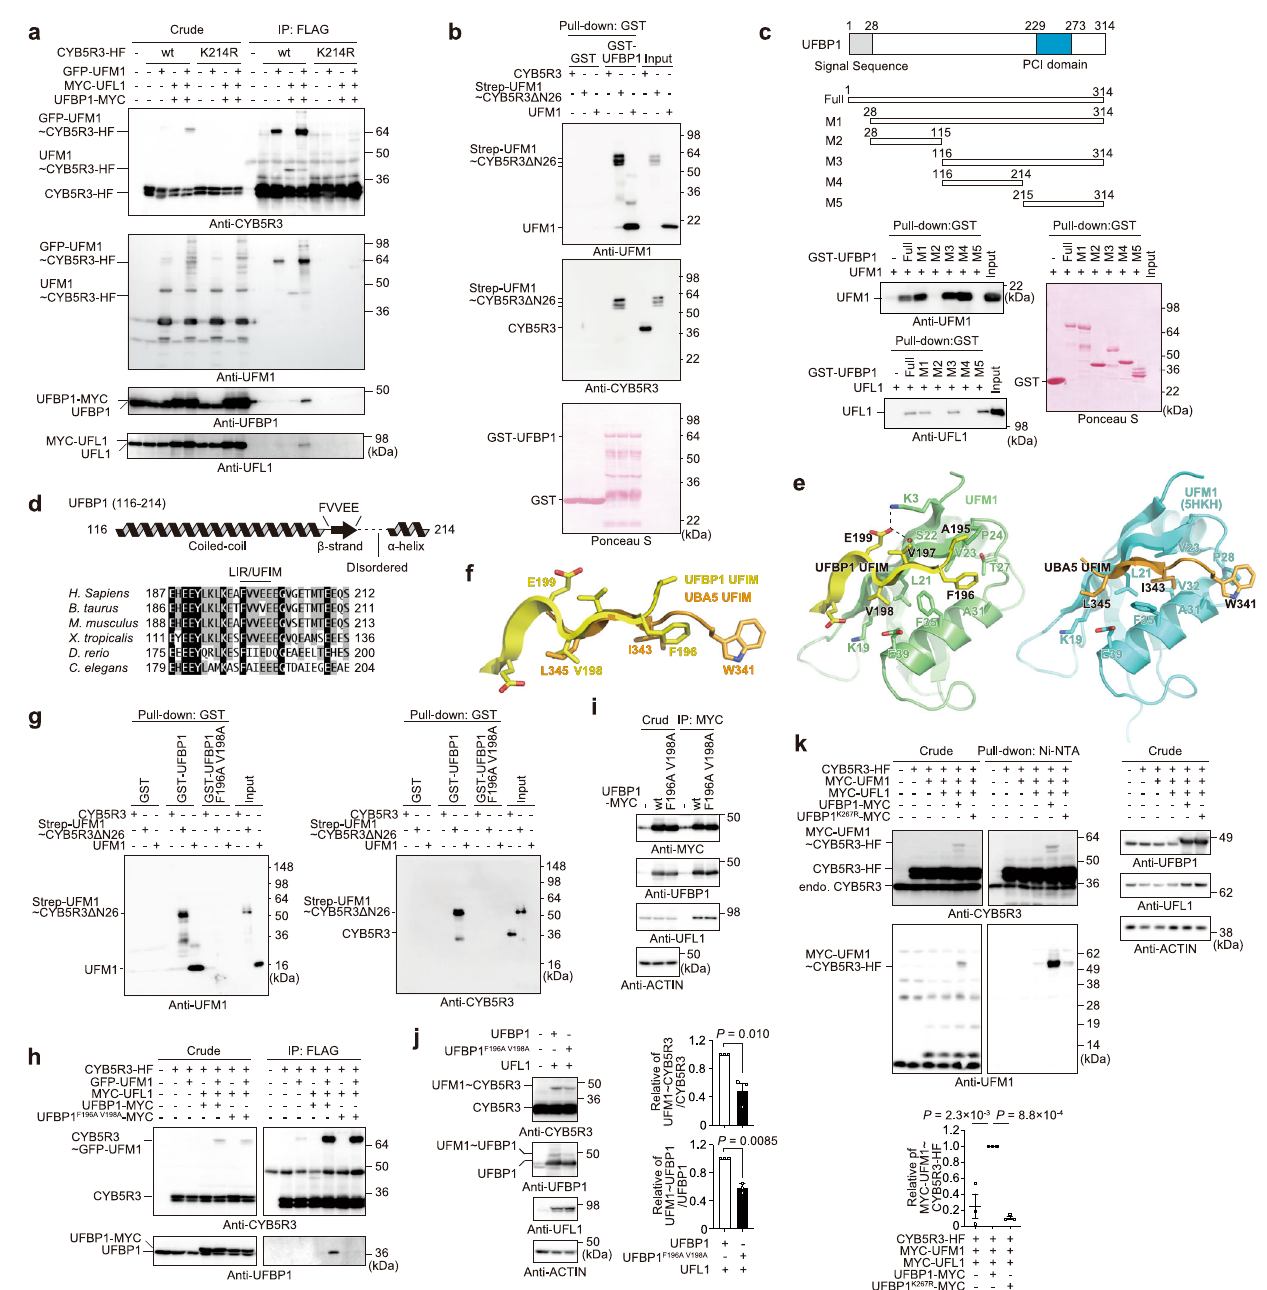
Fig. 4 | Ufmylated CYB5R3 interacts with UFBP1. a CYB5R3 − / − UFSP2 − / − HEK293T expressing indicated constructs were lysed and then subjected to immunopreci- pitation. b – c In vitro pull-down assay. The amount of each protein bound to GST- UFBP1 was estimated by immunoblot ( b ). The faster-migrating ufmylated CYB5R3 Δ N26 proteins are most likely degradation products due to long-term storage and freeze – thawing. UFM1 and UFL1 binding to GST-UFBP1 and each mutant was estimated by immunoblot ( c ). d Top, analysis of the secondary struc- ture of UFBP1 (116 – 214) using PSIPRED/DISOPRED 61,62 and COILS 63 . Bottom, align- ment of UFIM of UFBP1. e Crystal structure of UFM1 complexed with the UFIM of UFBP1(left)ortheUFIMofUBA5(right,PDB5HKH).Thesidechainsoftheresidues involved in the UFM1-UFIM interaction are shown with a stick model. Broken lines indicate possible hydrogen bonds. f Structural comparison between UFBP1 and UBA5UFIMscomplexedwithUFM1.The fi gurewaspreparedbysuperimposingthe structure of the UFIM moiety of UFBP1-UFM1 onto that of UBA5 UFIM-UFM1. g In vitro pull-down assay. The amount of each protein bound to GST-UFBP1 was